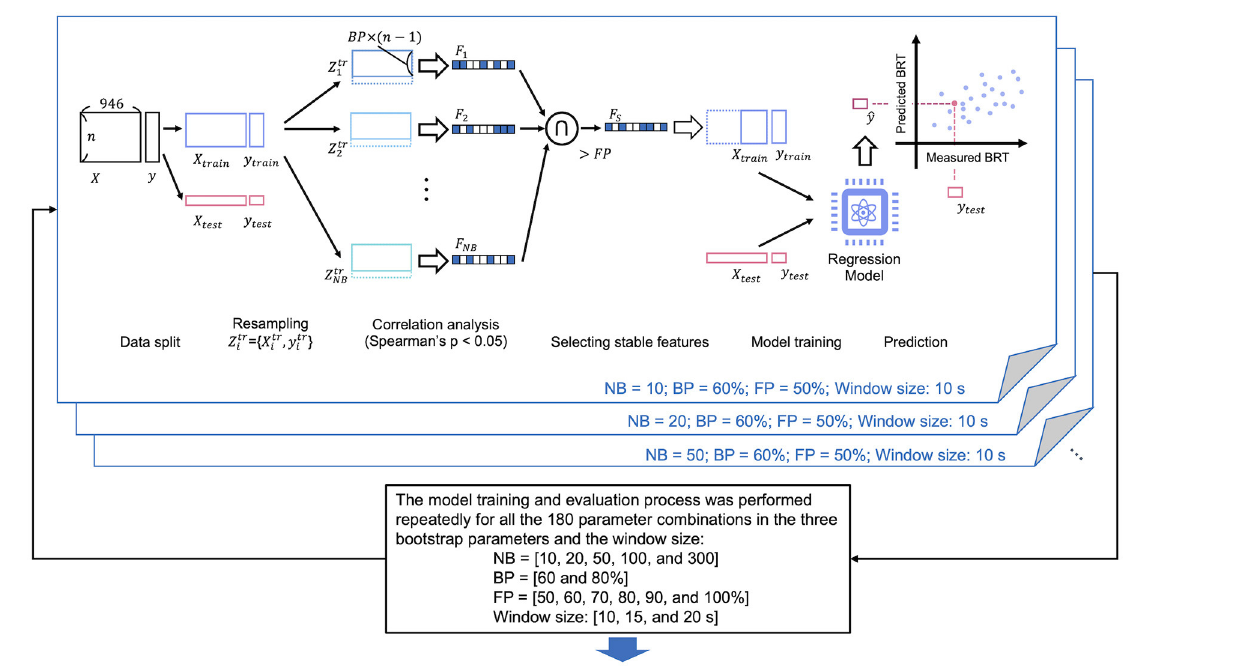
FIGURE 3 | The overview of our proposed method to build a predictive model of distracted driving. Cross-validation and feature selection were incorporated into the model-building process. The model was constructed for each participant using the dataset from multiple car braking trials. NB, number of resampling; BP, proportion of sampling; FP, stability of the